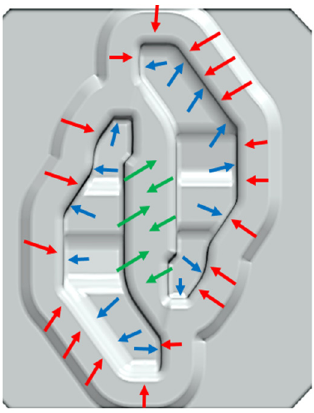
Figure 12. The areas of the dominant wear mechanisms on the surface of the forging tool: erosive tribological (green arrow), fatigue cracking (blue arrow), and white layer formation (red arrow).